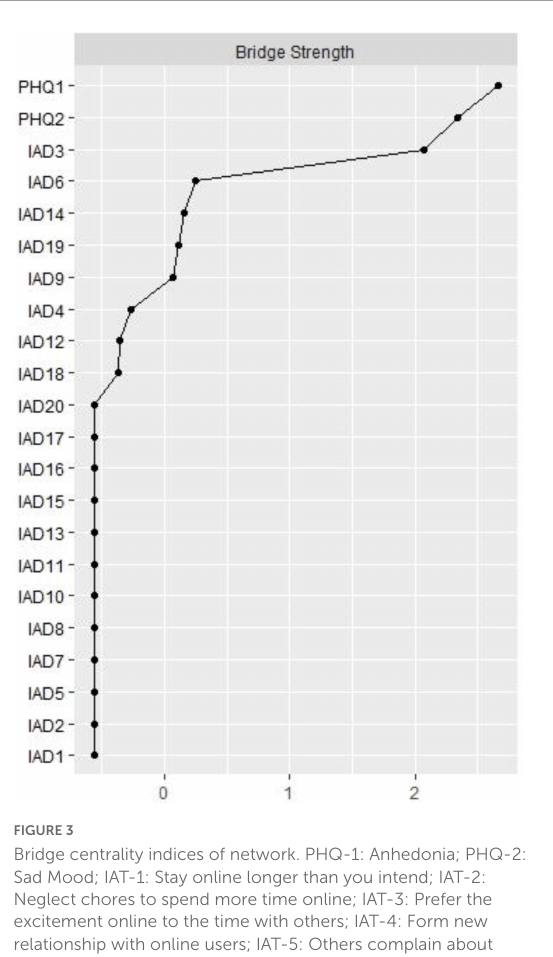
FIGURE3 Bridge centrality indices of network. PHQ-1: Anhedonia;